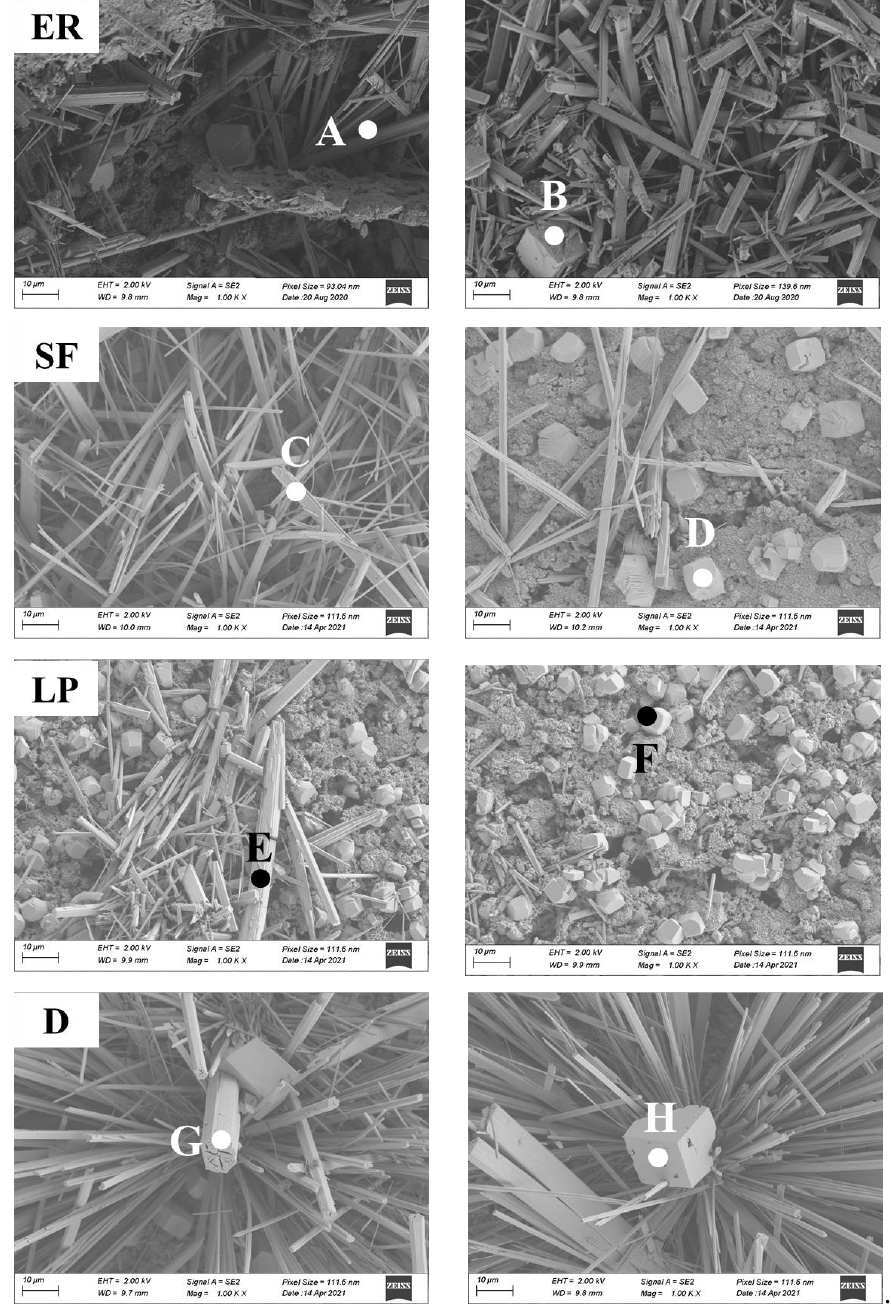
Figure 6. SEM images of efflorescence substances on cement pastes.